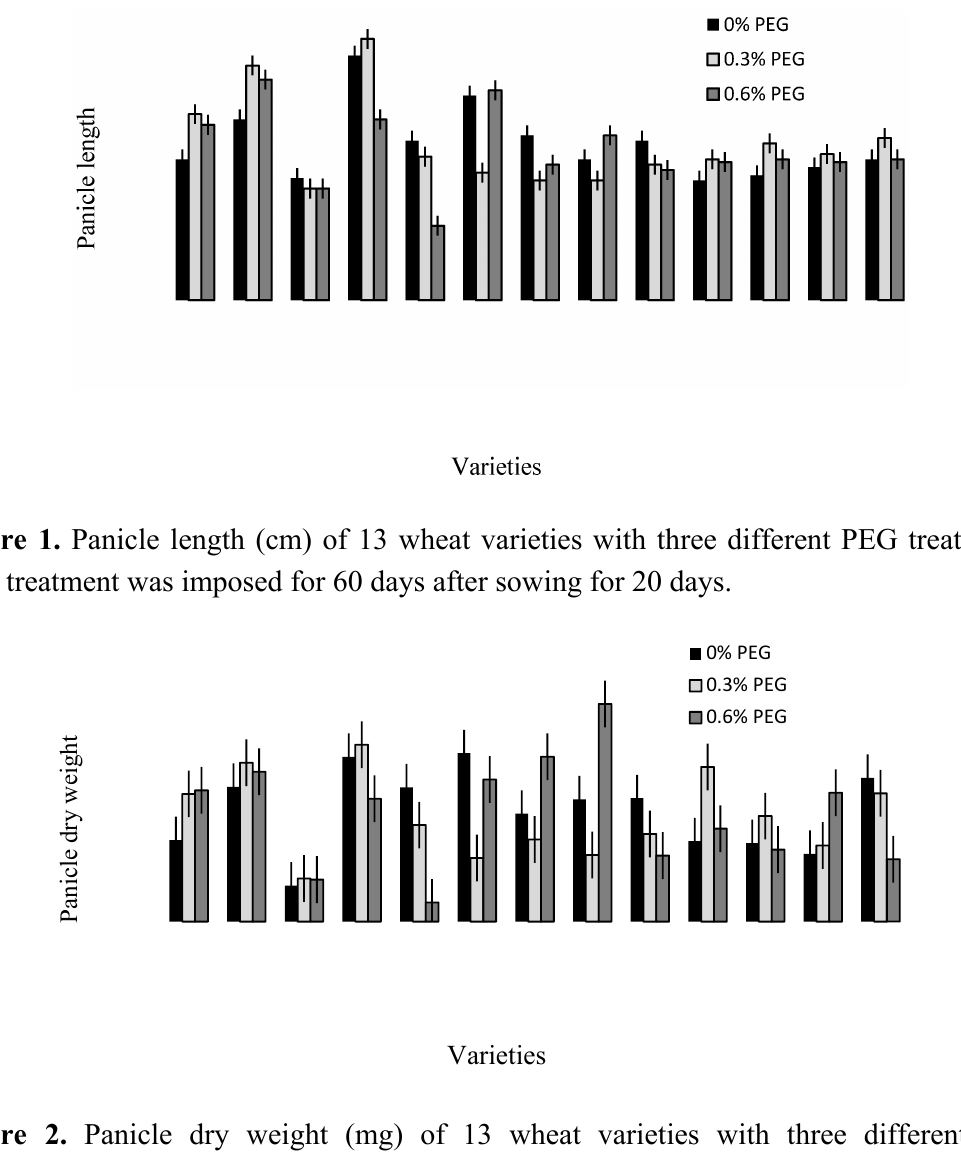
Figure 2. Panicle dry weight (mg) of 13 wheat varieties with three different PEG treatments. PEG treatment was imposed for 60 days after sowing for 20